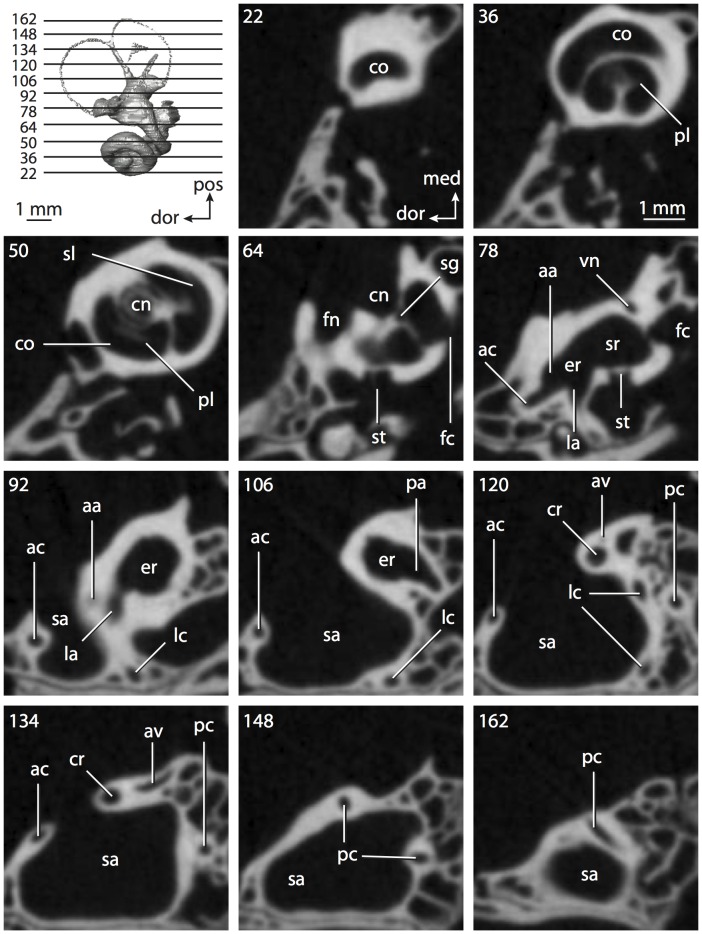
CT slices through ear region ofPteropus lylei.Abbreviations listed at the end of the Materials and Methods section.